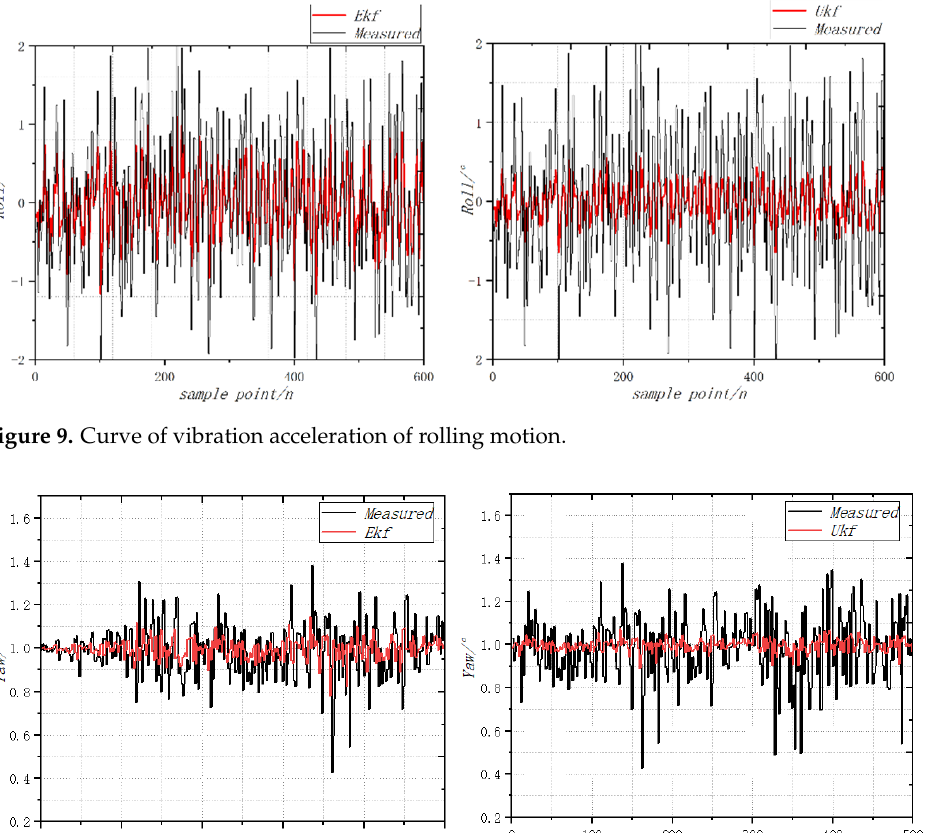
Figure 8. Variation curve of vibration acceleration in pitching motion.